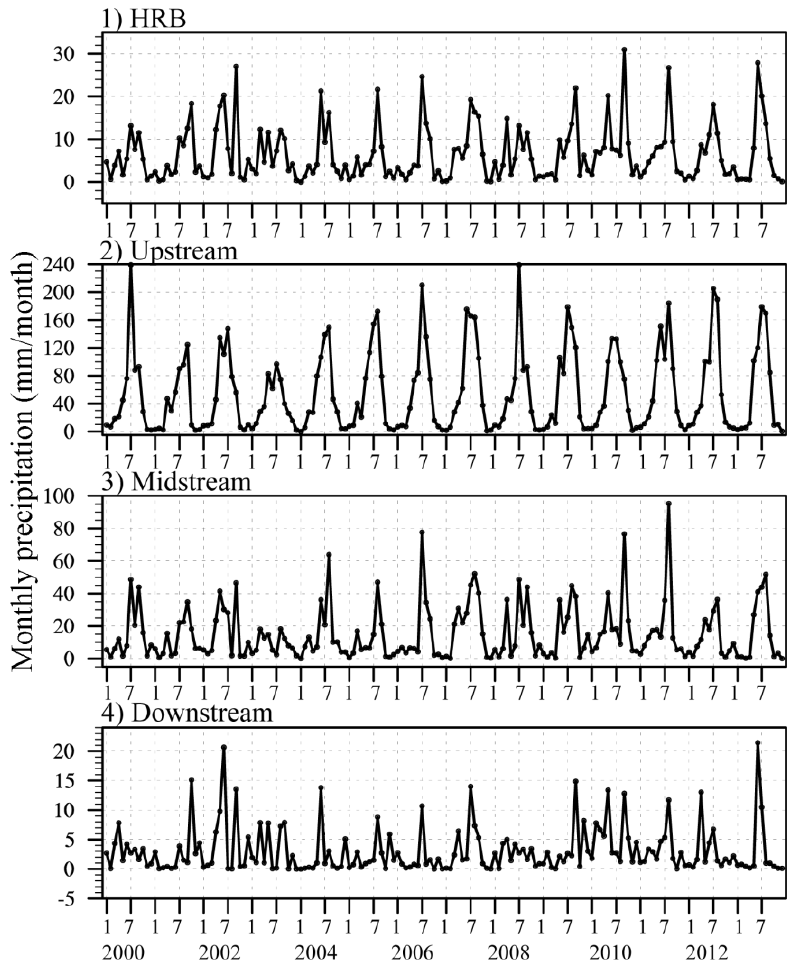
Figure 11. Time series of monthly precipitation for the HRB, and its upstream, midstream, and downstream areas from 2000 to